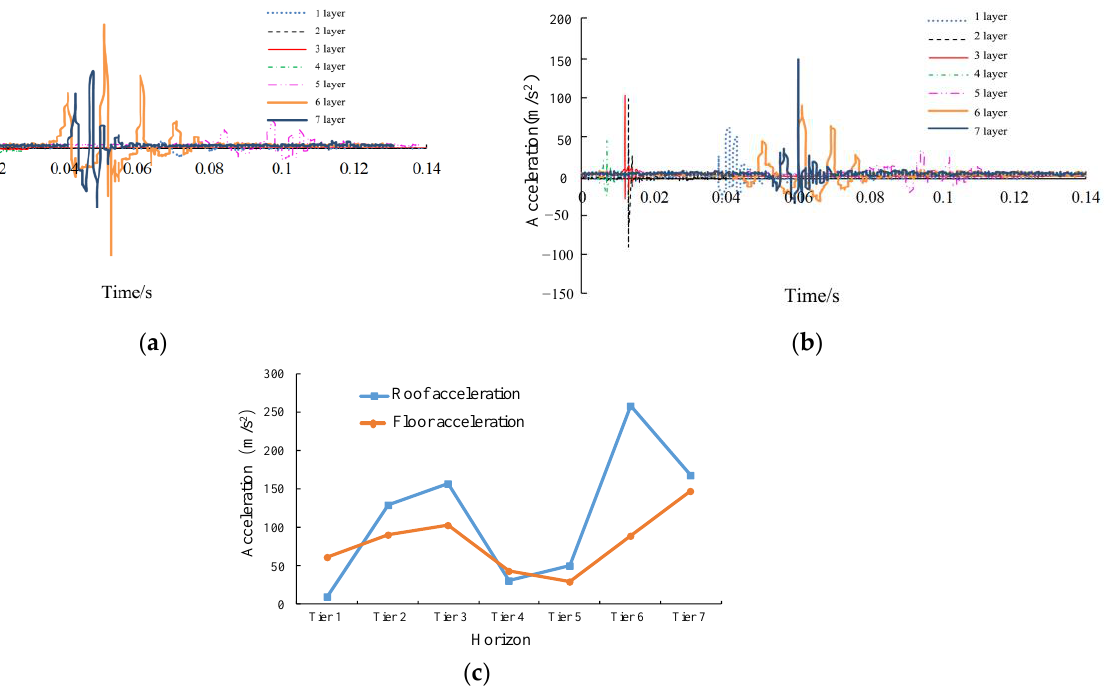
Figure 15. Acceleration response characteristics of each layer when the pendulum height is 0.1 m. ( a ) Acceleration at the roof of surrounding rock; ( b ) Acceleration at the floor of the roadway; ( c ) Peak acceleration at each level.